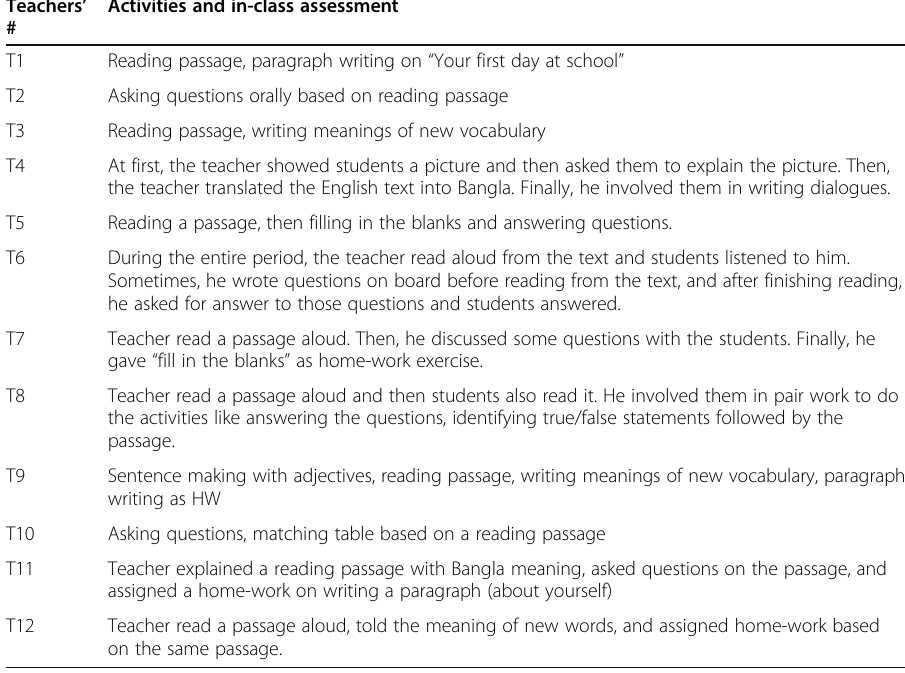
Table 4 Classroom activities and assessment practice Teachers ’ Activities and in-class #